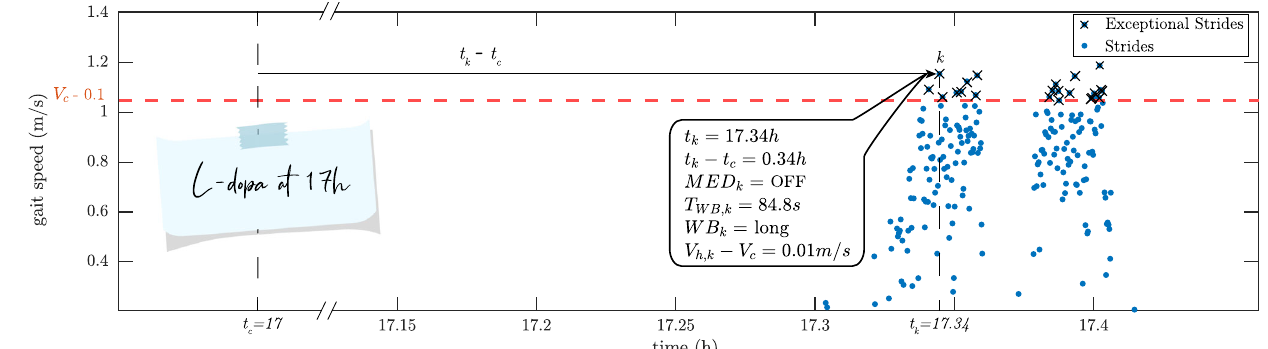
Fig. 6 The information extracted for Exceptional Stride k for one of the patients as an example. Each blue dot shows the gait speed of a gait cycle at a speci fi c time of the day during daily activities. This patient took Levodopa at time t c ¼ 17h . V c is the capacity of the patient, i.e., gait speed during fast walking test in the clinic. The Exceptional Strides have marked with black crosses. k is one example of the Exceptional Strides with the information extracted according to section II-F. No walking with a duration of more than 15 s occurred after 17 h and before 17.3 h. straight walk tests represent the patients ’ higher preferred gait Table 2. The parameters of Exceptional Strides for all the patients speed during daily activities. except P2, P7, P15, and Comparison of the bimodal distribution between clinic and home showed that patients had on average the same preferred gait speeds in both of the settings (Table 1). There was a signi fi cant difference between the two settings for the variations from the lower preferred gait speed ( σ 1 ) but not from the higher gait speed ( σ